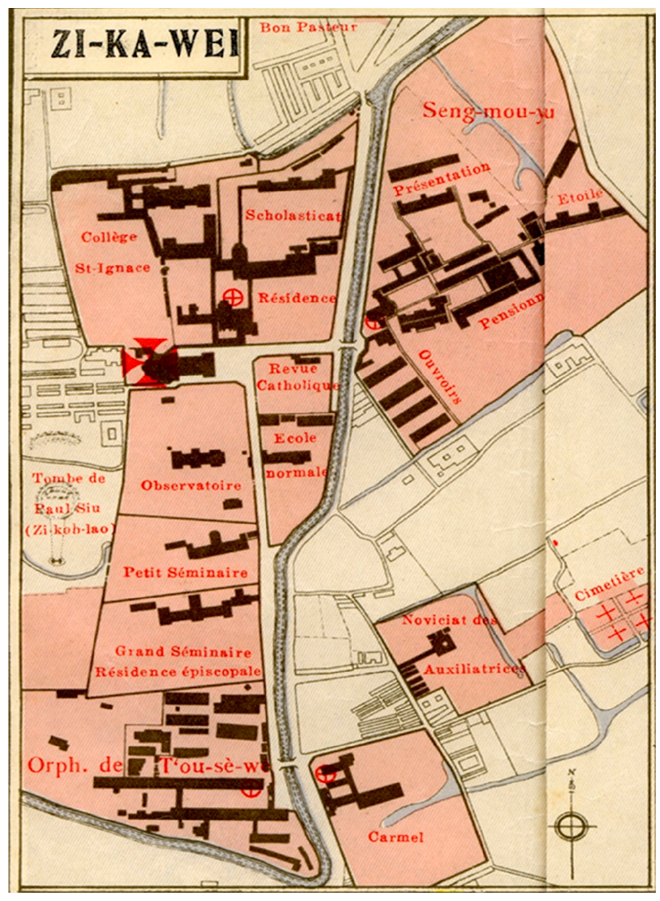
Figure 1. A bird’s-eye view of the Jesuit Zi-ka-wei Compound from the Map of Shanghai Catholique , 1933, Printed by Impr. de T’ou-sè-wè près Zi-ka-wei.